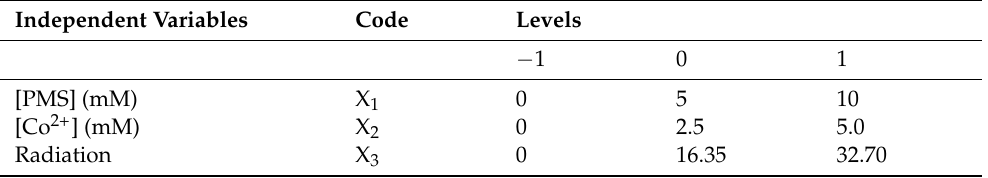
Table 2. Symbols and coded factor levels for the considered